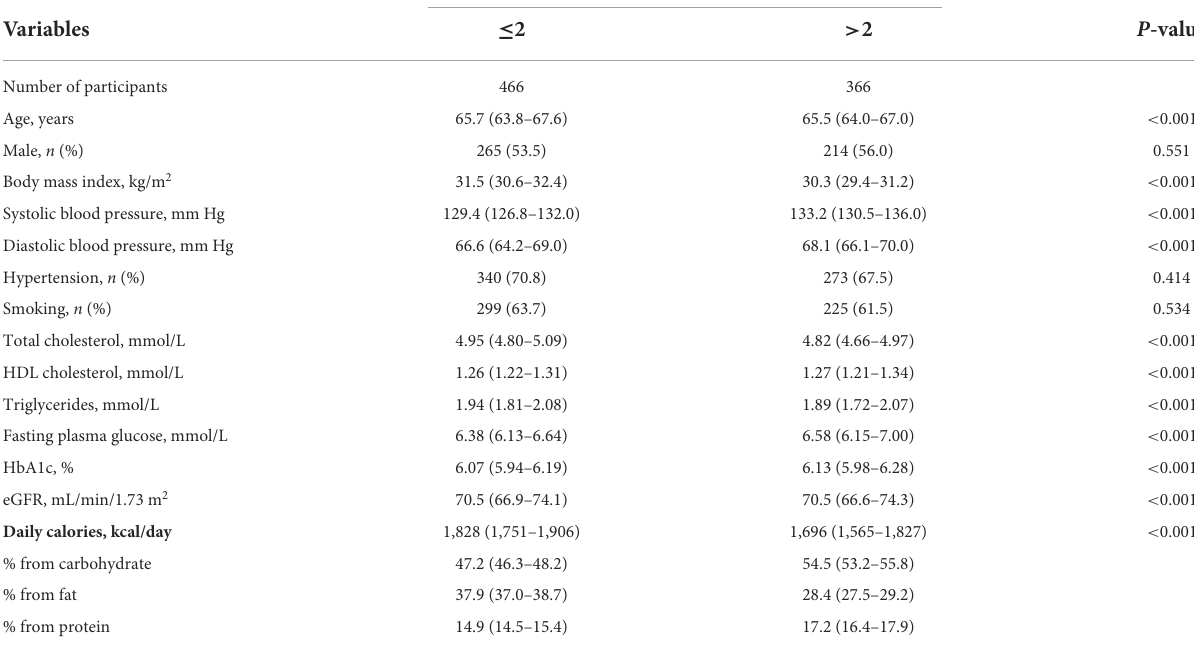
TABLE 2 Characteristics of study participants according to DASH